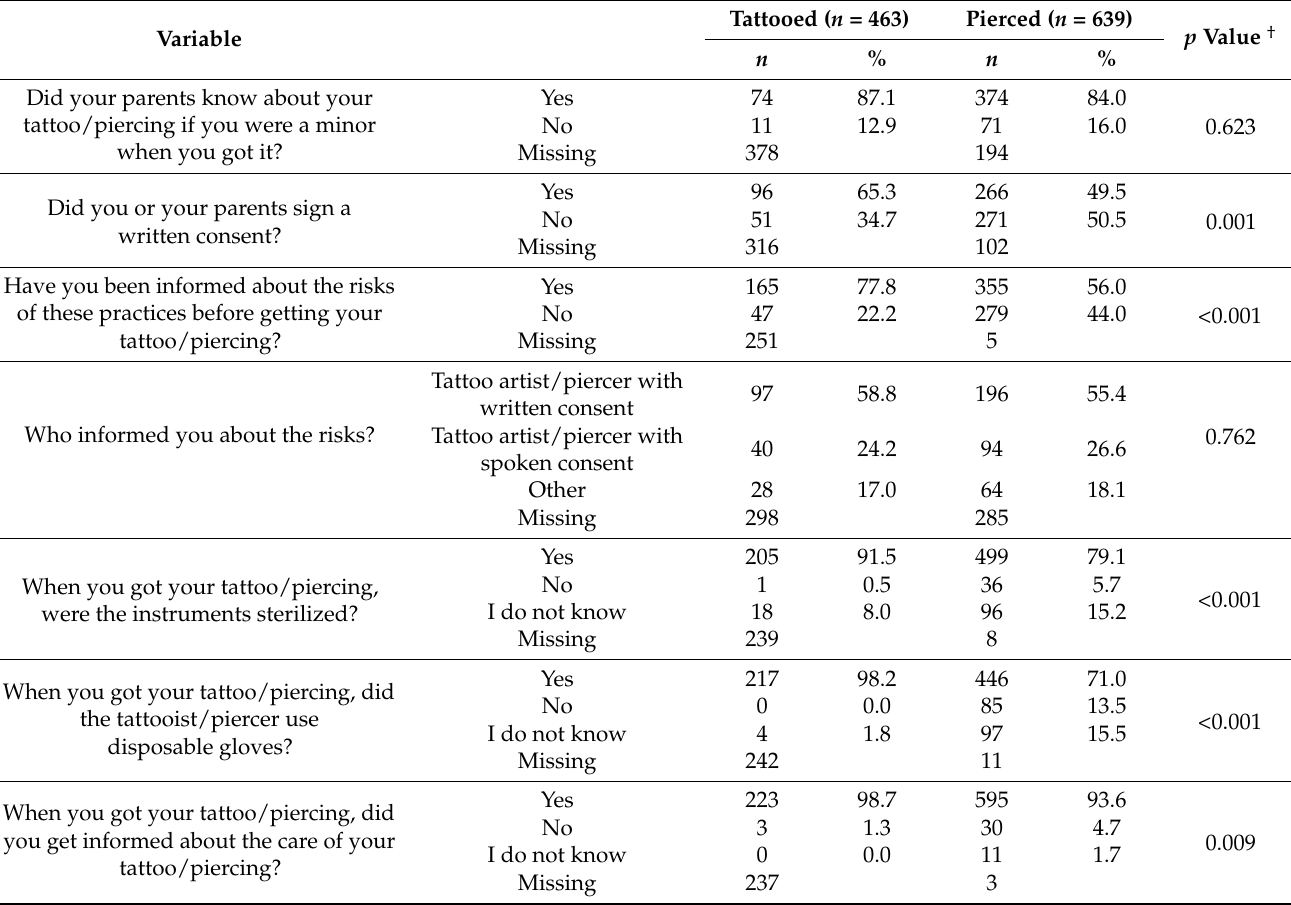
Table 3. Answers related to tattooing or body piercing procedure experienced by participants ( n = 1102).